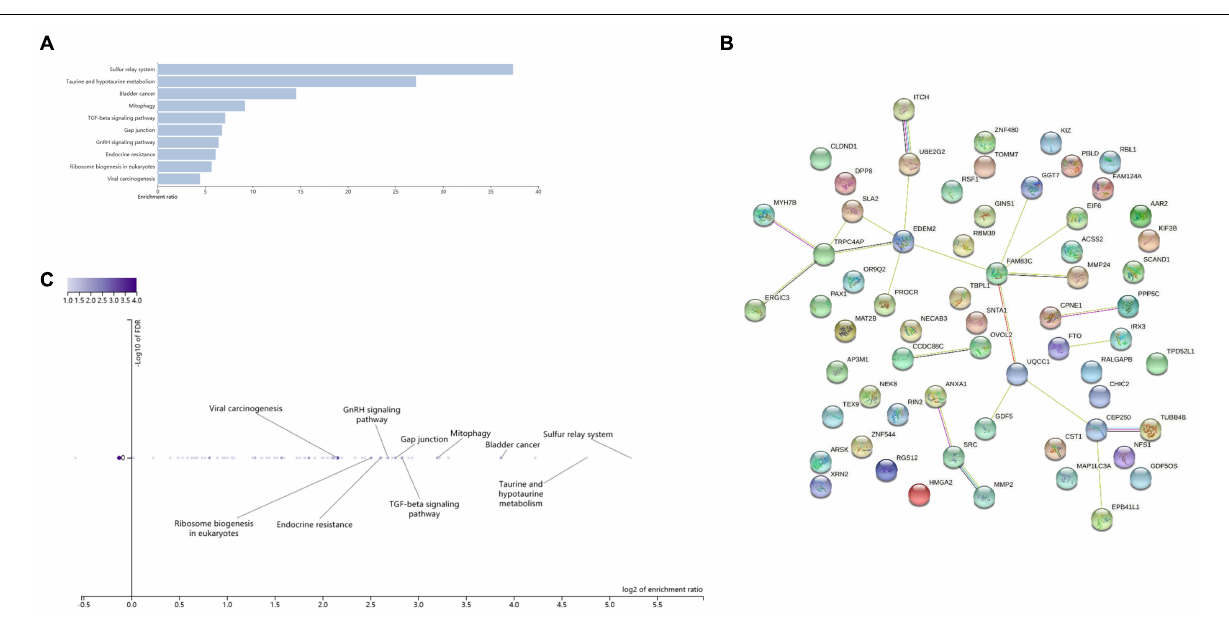
FIGURE 6 | KEGG enrichment analysis and PPI network diagram of significant SNPs probability regulating associated genes expression. (A) Bar chats of KEGG enrichment analysis; (B) Volcano plot of KEGG enrichment analysis; (C) PPI interaction network diagram, data are from